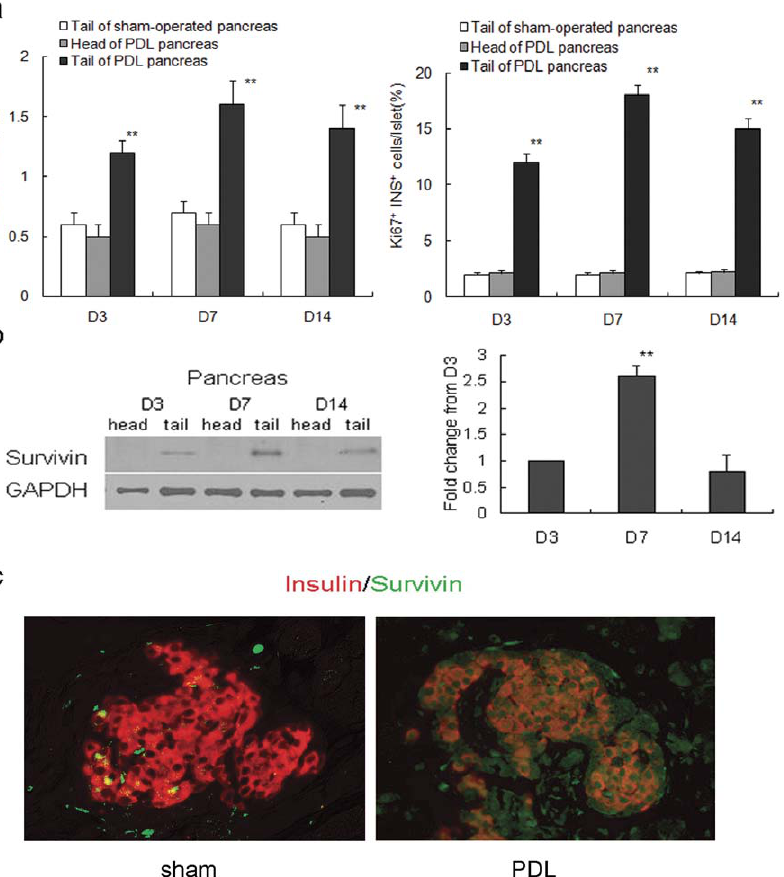
Figure 1. PDL activates survivin expression and promotes beta-cell mass expansion. (a) PDL markedly increased beta-cell mass (left panel) and beta-cell proliferation (right panel) in the tail part of pancreas (black bars) at day 3, 7 and 14 as compared to the unligated head of the same pancreas (gray bars) and the tail of a sham-operated pancreas (white bars) (n=5 at each time point). **P , 0.01. (b) Western blots (left panel) and quantification (right panel) show that survivin expression is detected in the ligated tail of 8-week-old mouse pancreas from PDL day3 to 14 (n=5 at each time point). Compared to D3, **p , 0.01. (c) Immunofluorescent staining shows that survivin is not expressed in the whole pancreas in the tail of day 7 sham-operated pancreas, but reexpressed throughout the pancreatic epithelium including islet beta cells in the tail of pancreas at PDL day 7 (original magnification, 6 200). The data represent as means 6 SE.